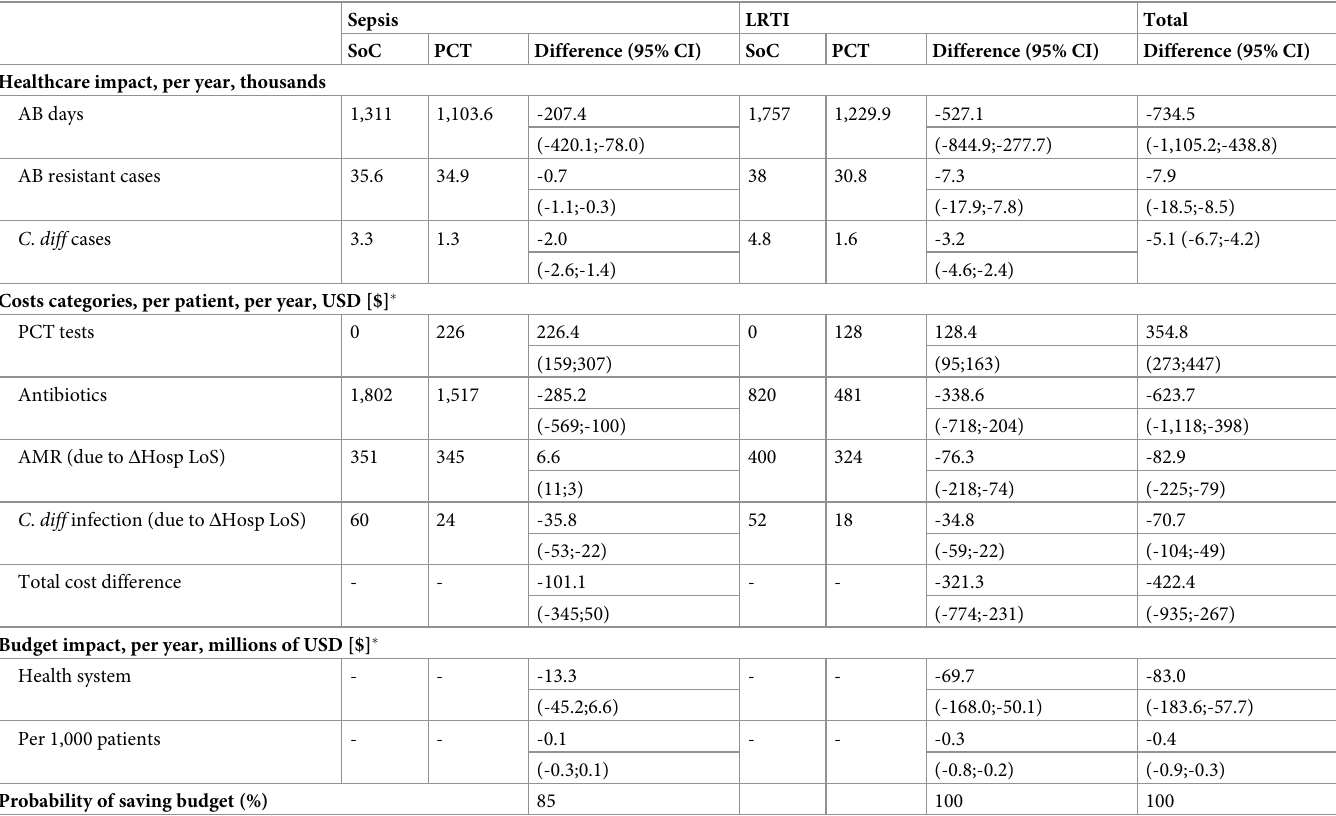
Table 2. Expected results. Healthcare impact, cost categories, per patient and budget impact. Sepsis and LRTI patients. Standard of care, PCT strategy and differences. Year 1. Costs expressed in US dollars. Argentina, 2020. Sepsis LRTI